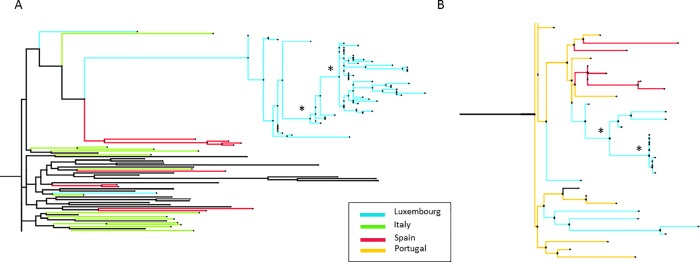
Phylogenetic trees of the two PWID HIV-1 subtype B and CRF14_BG clusters from Luxembourg related to sequences from other countries.A. Phylogenetic tree of the PWID HIV-1 subtype B cluster. This cluster of 52 sequences from Luxembourg are related to sequences from Luxembourg, Italy and Spain. * SH value ≥ 0.95. All other SH values in the cluster were above 0.8. Diamonds represent the node of a sequence in the tree. B. Phylogenetic tree of the PWID HIV-1 CRF14_BG cluster of 10 sequences. This cluster of 10 sequences from Luxembourg are closely related to sequences from Spain and Portugal. * SH value ≥ 0.95. All other SH values in the cluster were above 0.76. Diamonds represent the node of a sequence in the tree.